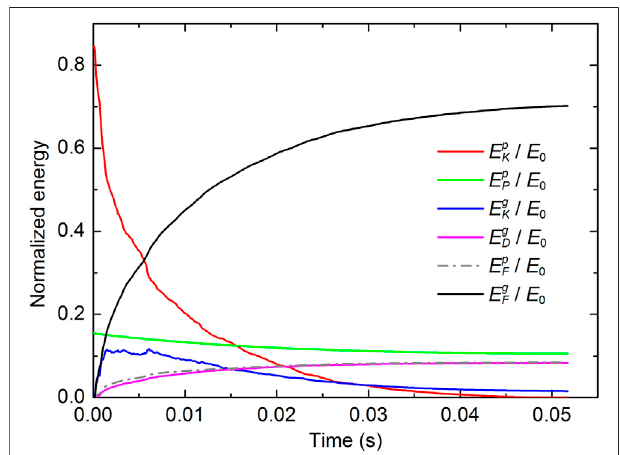
FIGURE 9 | Evolution and transformation of energy components during a simulation of v 0 = 5.0 m/s. All the energy components are normalized by the initial mechanical energy (kinetic energy plus potential energy) of the projectile ( E 0